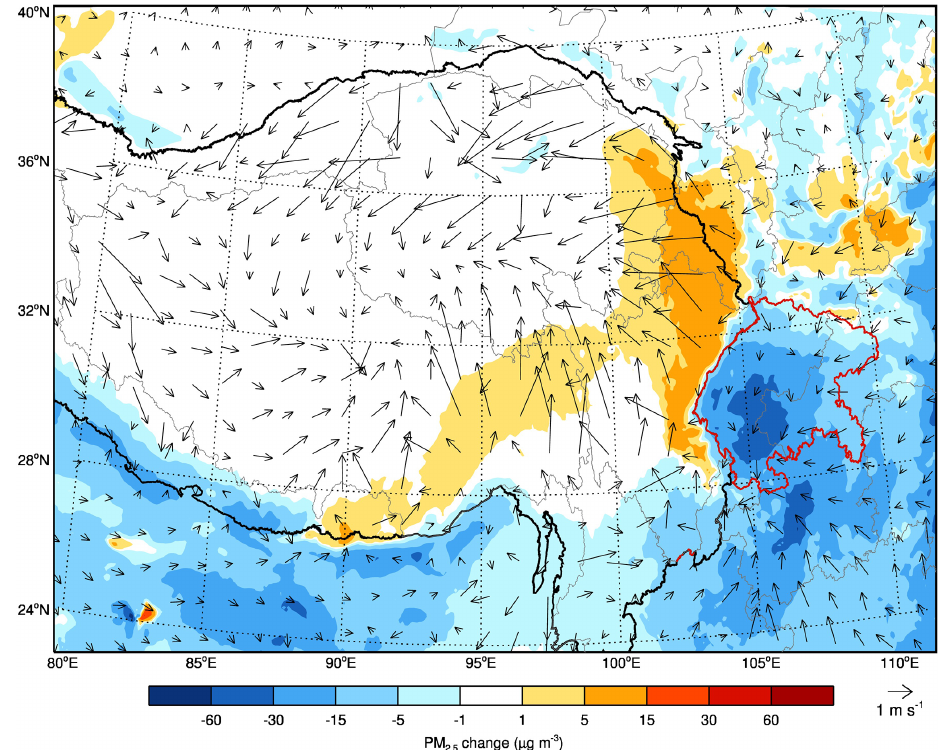
Figure 7. Difference in spatial distributions of surface PM 2 . 5 concentration (shading) and winds (arrows) between the sensitivity simulation and baseline simulation. Negative values show PM 2 . 5 concentration decreases and the positive values show PM 2 . 5 concentration increases when the Tibetan Plateau warms by 2 ◦